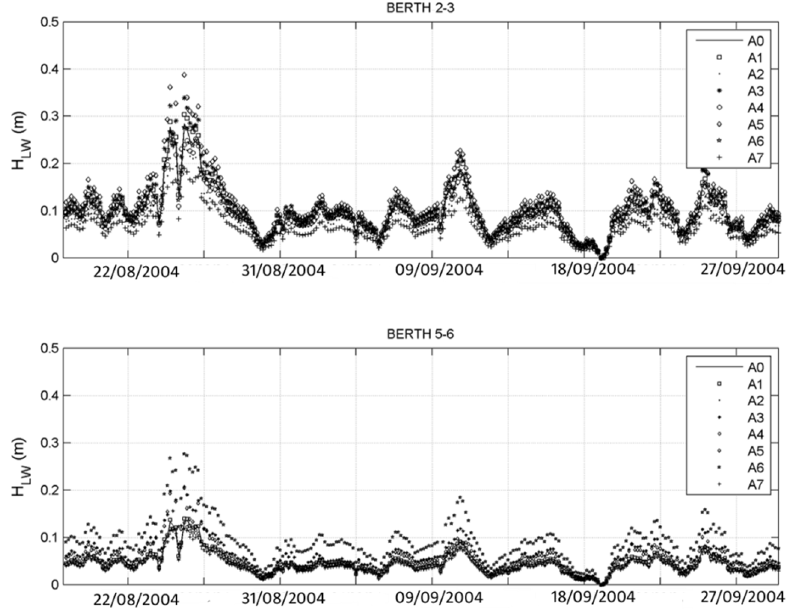
Figure 9. Comparison of HLW for the different harbor layouts proposed for year 2004 at Berths 2 to 3 and 5 to 6. A1, Alternative 1.